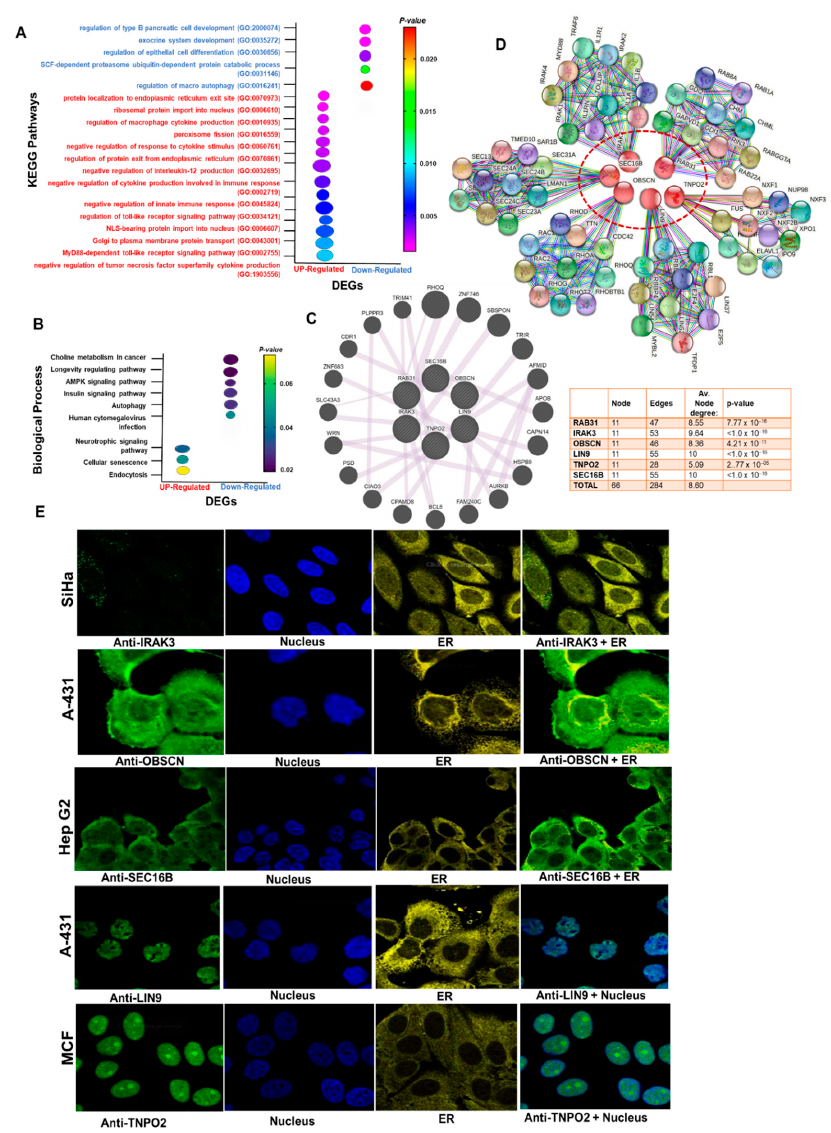
Figure 4. Enrichment and interaction analysis of the DEGs. ( A ) Bubble plot of KEGG pathway enrichment analysis of DEGs. ( B ) Bubble plot of GO biological enrichment analysis of DEGs. GO and pathways enrichment is ranked by their p -value. KEGG, Kyoto Encyclopedia of Genes and Genomes. ( C ) Cycle plot of the DEGs’ ( C ) gene–gene and ( D ) protein–protein interaction network (PPI). Node sizes are based on the degree of connectivity of the nodes. ( E ) Immunofluorescence stain of the subcellular distribution of the hub genes within the nucleus and ER of cancer cells. Gene localizations were detected based on immunofluorescence microscopy of HPA database using the following antibodies: IRAK3 (#HPA043097), OBSCN (#HPA021186), LIN9 (#HPA030241), TNPO2 (#HPA071498), SEC16B